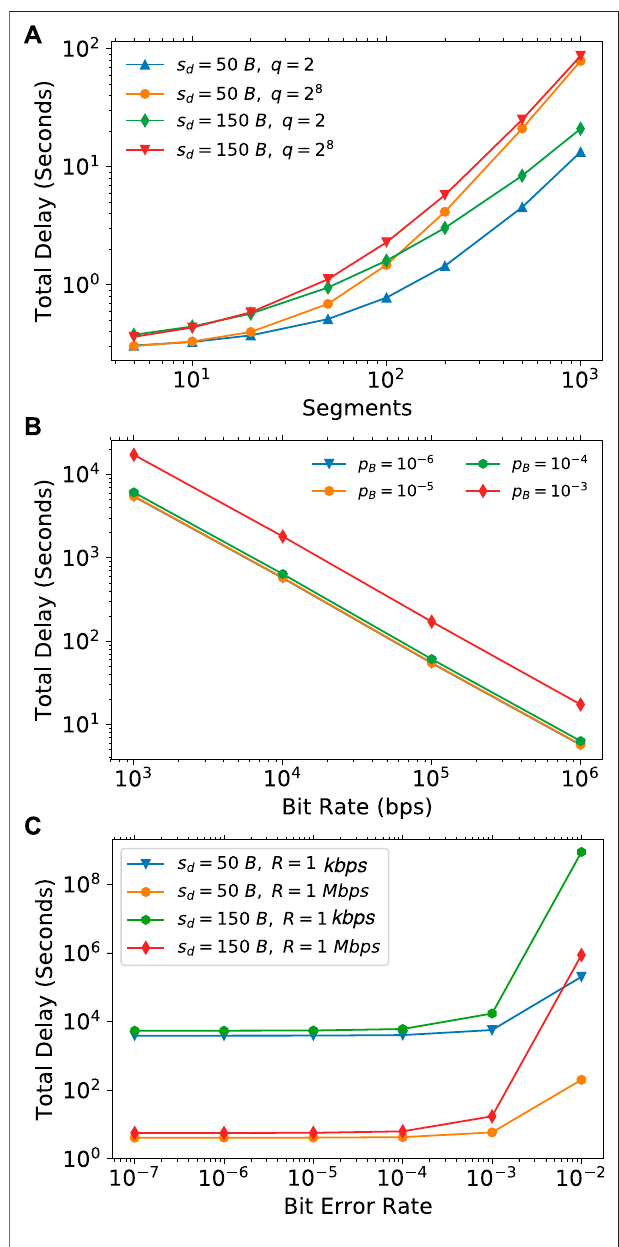
FIGURE 5 | Relationship between the total delay and (A) the number of segments for data segment sizes of 50 and 150 bytes, and GF sizes of q (cid:2) 2 and q (cid:2) 2 8 , (B) bit rate for BERs ranging from 10 − 6 to 10 − 3 , q (cid:2) 2 8 , and (C) BERfor datasegmentsizesof50and 150 bytes, q (cid:2) 2 8 ,and bitratesof 1 kbps and 1 Mbps. s a (cid:2) 20 bytes in all